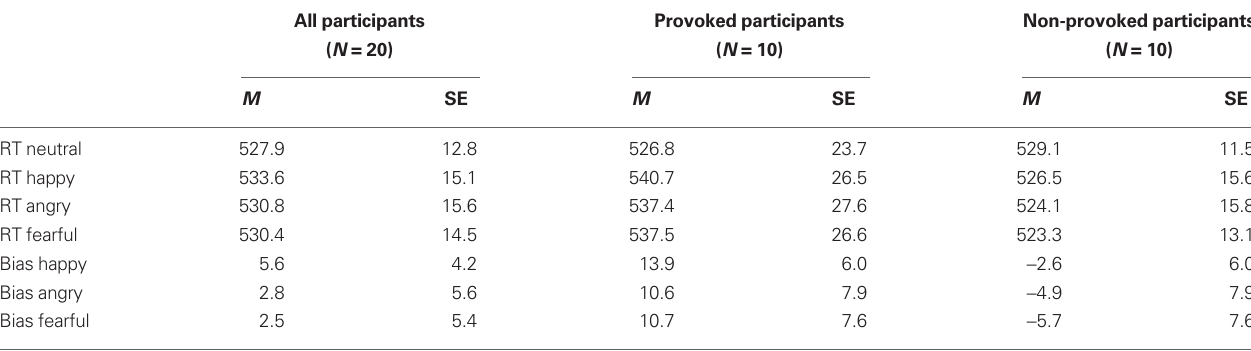
Table 1 | Reaction times and bias scores in the emotional Stroop task (mean values and standard errors). All participants Provoked